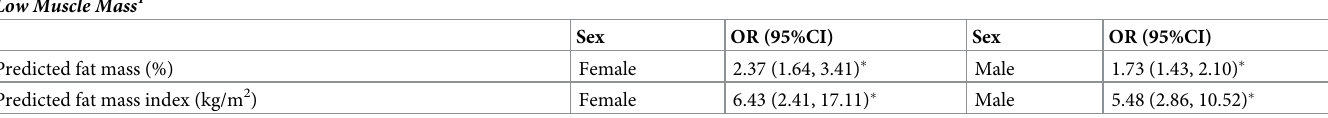
1 ALM with dual energy X-ray absorptiometry measurement, for women, ALM < 15kg, for men, ALM < 20kg [10]. 2 FMI with dual energy X-ray absorptiometry measurement, for women, FMI > 13kg/m 2 , for men, FMI > 9kg/m 2 [14].